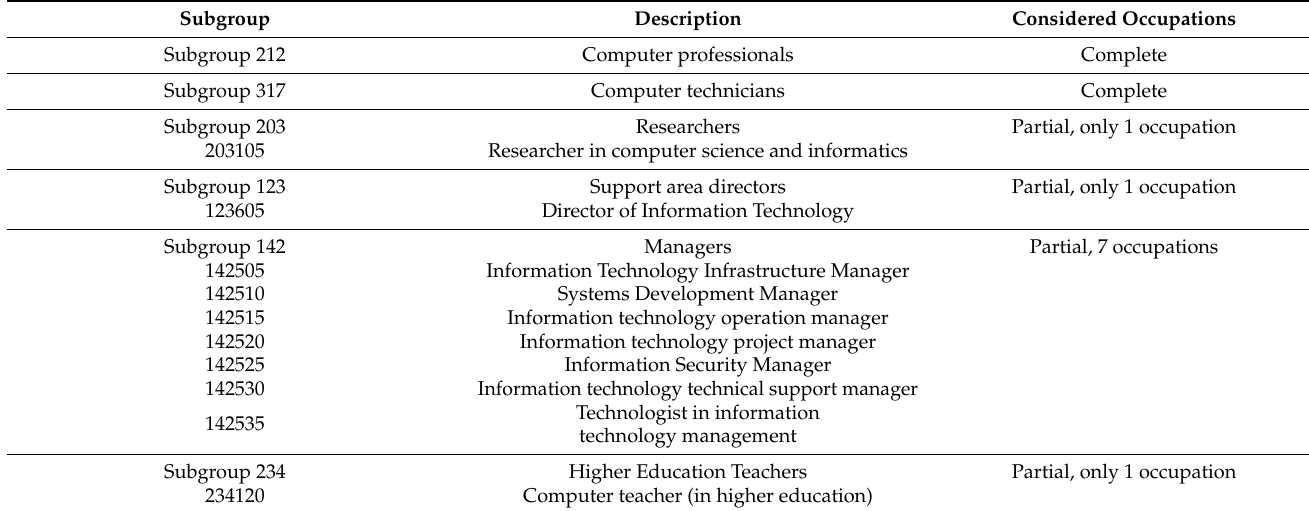
Table 1. Occupations considered in this research, considering the Brazilian Classification of Occupations